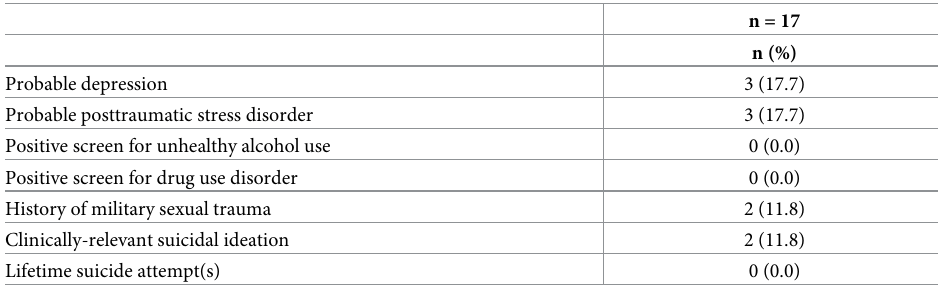
Table 2. Mental health